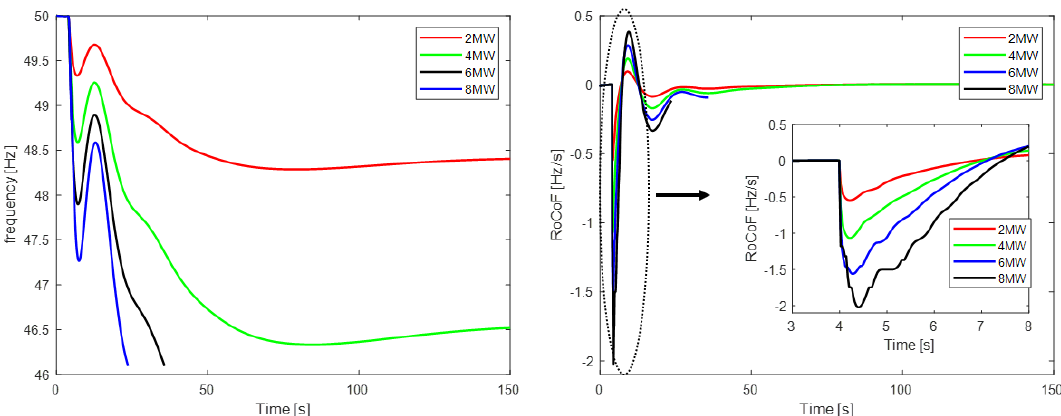
Figure 9. Load step-change frequency response and RoCoF for the best case of the future scenario.